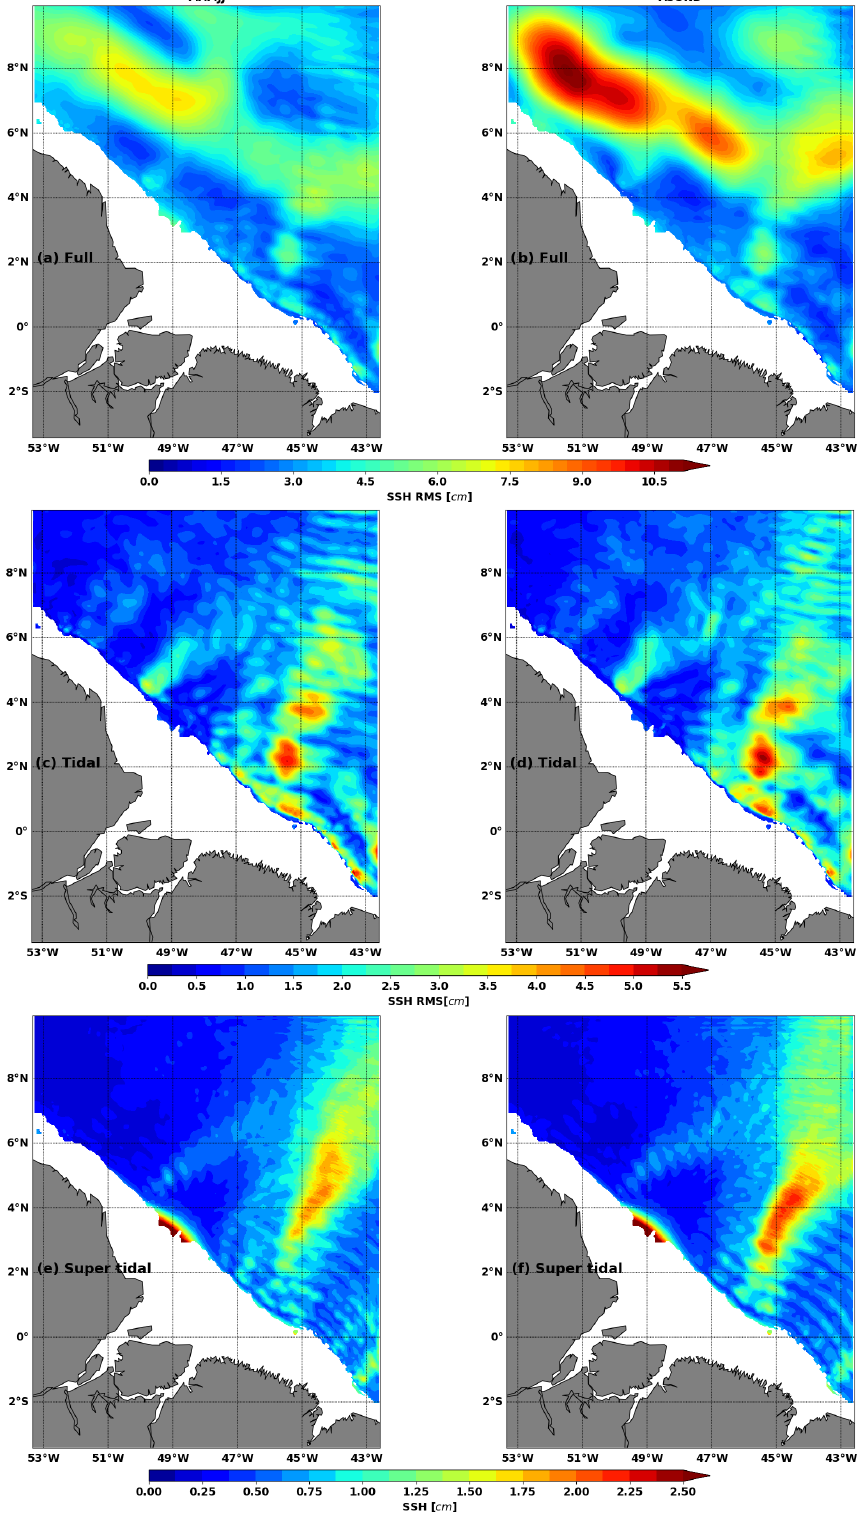
Figure 10. Root means square (rms) of SSH1 for (a, b) all frequencies (full), (c, d) tidal frequencies (1 / 28h − 1 < f < 1 / 11h − 1 ), and supertidal frequencies ( f > 1 / 11h − 1 ) during MAMJJ (a, c, e) and ASOND (b, d, f) . SSH1 is the residual between the SSH and the coherent barotropic SSH (SSHBT); see Eq. (8). Units: cm. Bathymetry less than 100m is